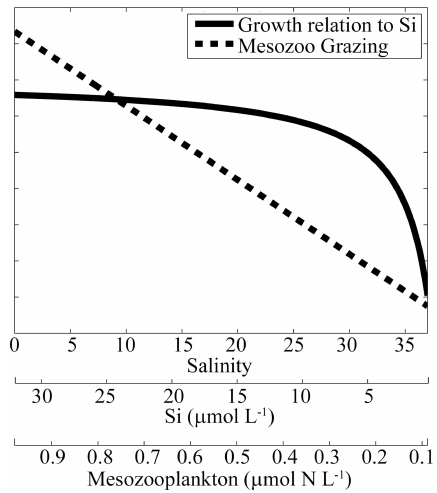
Figure 13. Conceptual diagram of the relationship of DDA growth and loss rates to conservative mixing losses of Si and mesozoo- plankton along the salinity gradient. Note that we have put no val- ues on the y axis since actual grazing rates will be dependent on the concentrations of all phytoplankton taxa and growth rates are de- pendent on light, both of which vary along the salinity gradient. Plot is only intended to show the different shape of DDA net growth rate responses to conservative mixing losses of nutrients and